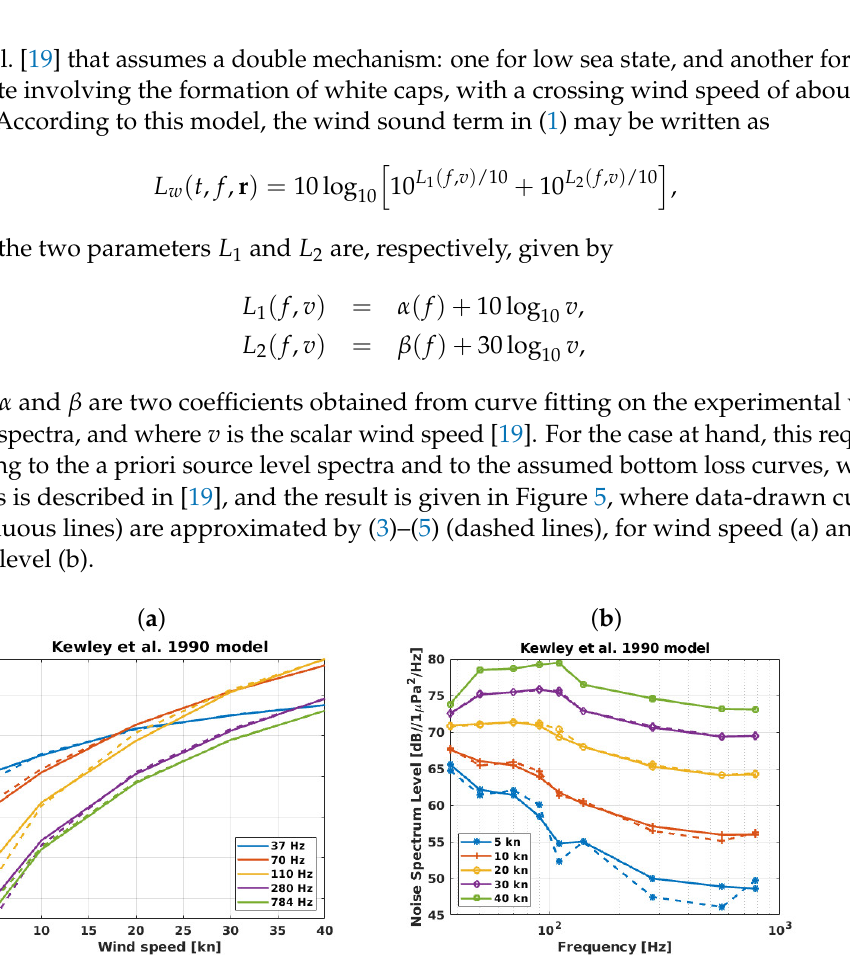
Figure 5. Kewley et al. [19] empirical wind sound model nonlinear least squares fitting of data drawn model (continuous lines) with (3) (dashed lines) for noise level as a function of: wind speed ( a ) and frequency ( b